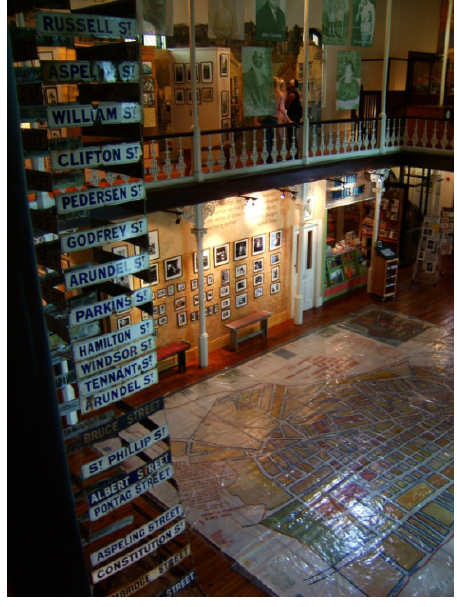
Figure 17. Interior view of District Six Museum, Cape Town, showing floor map and street signs (author’s